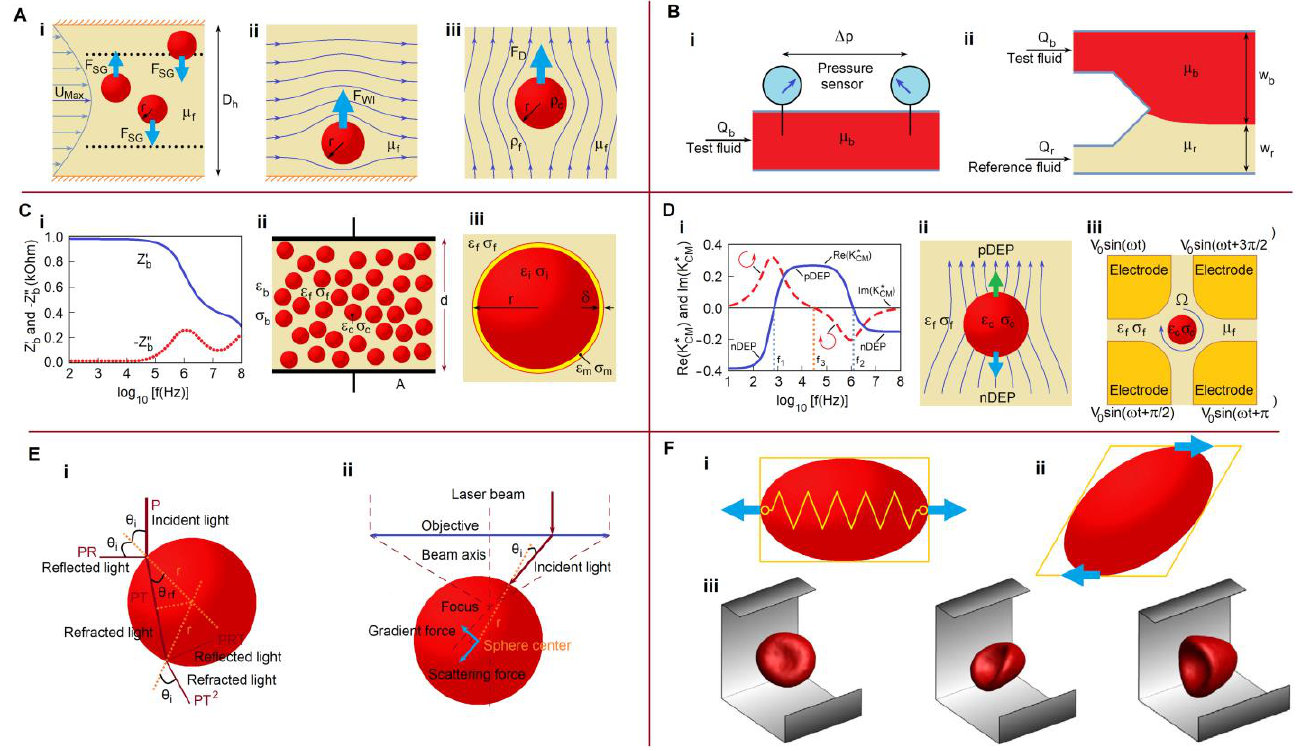
Figure 2. Overview of physical forces acting in microfluidic systems and effective properties of cell materials and cell suspensions. ( A ) Essential forces acting on particles in microfluidic channels: ( i ) shear-gradient lift force, ( ii ) wall-induced lift force, and ( iii ) drag force. ( B ) Direct and indirect methods for measuring viscosity: ( i ) pressure-sensing viscometer and ( ii ) co-flowing stream viscometer. ( C ) Electrochemical impedance spectroscopy of blood: ( i ) real and imaginary parts of the blood impedance, ( ii ) parallel plate measuring cell, and ( iii ) model of the coated spherical particle of an RBC. ( D ) Dielectrophoretic force and electrorotation torque: ( i ) real and imaginary parts of the Clausius–Mossotti factor, ( ii ) positive and negative dielectrophoresis, and ( iii ) four-pole electrode structure for rotating a dielectric particle. ( E ) Optical trapping of spherical particle: ( i ) reflection and refraction of incident light in spherical particle and ( ii ) contribution of an incident ray to scattering and gradient forces. ( F ) Mechanical properties of RBCs: ( i ) Young’s modulus and spring model, ( ii ) shear modulus, and ( iii ) change in the biconcave shape of RBCs at different flow conditions: tumbling, tank-treading, parachute shapes (from left to right). Image (F( iii )) was adapted with permission from [41]. Copyright 2019, Biophysical Society.